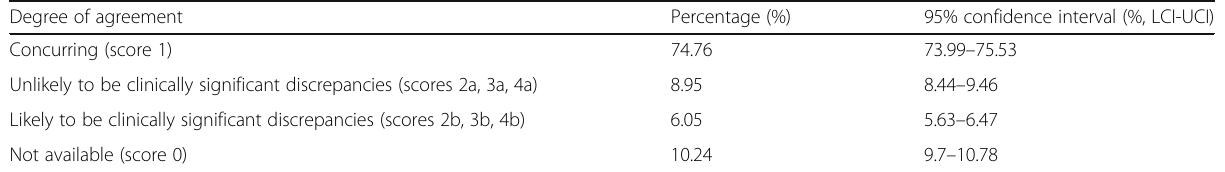
Table 3 Groups by the degree of agreement Degree of agreement